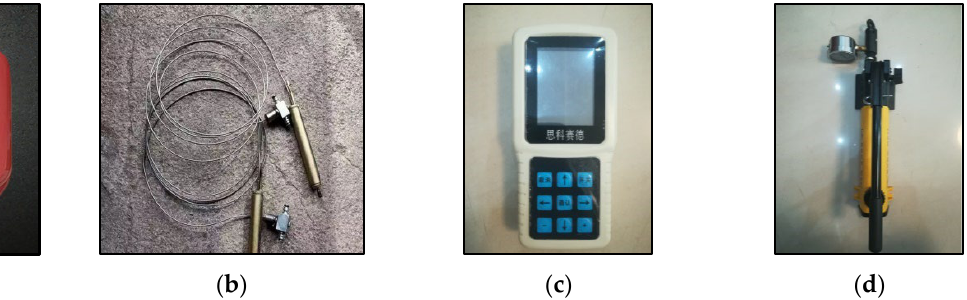
Figure 11. Borehole Stress Gauge Kit. ( a ) stress monitor; ( b ) borehole dynamometer; ( c ) stress collector; ( d ) pressurized oil pump.